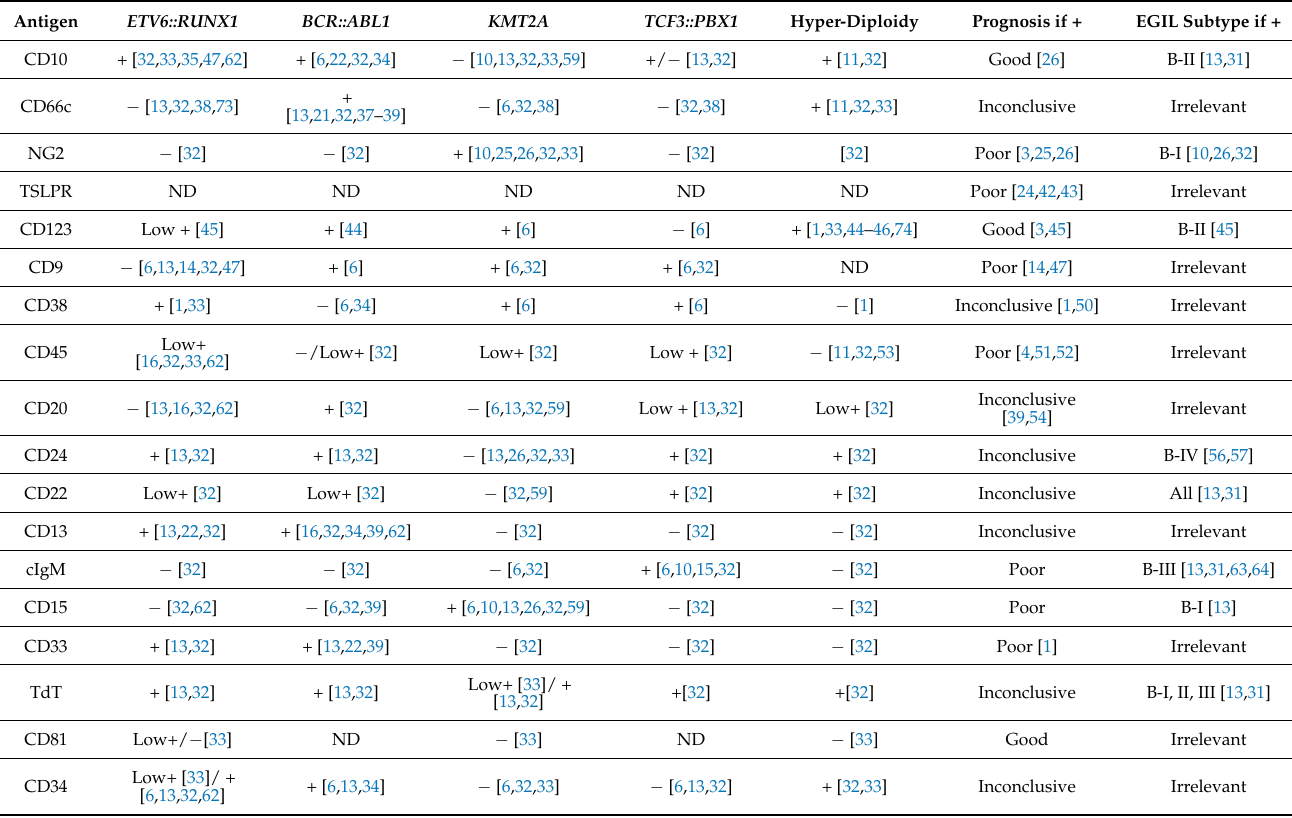
Table 2. Immunophenotypic features of studied genetic